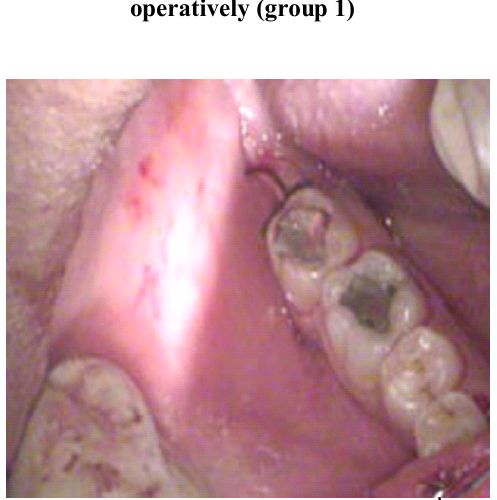
Figure (6) : Postoperative picture (3 rd postoperative day)For the site of operation (postoperative oedema subsided, no signs of